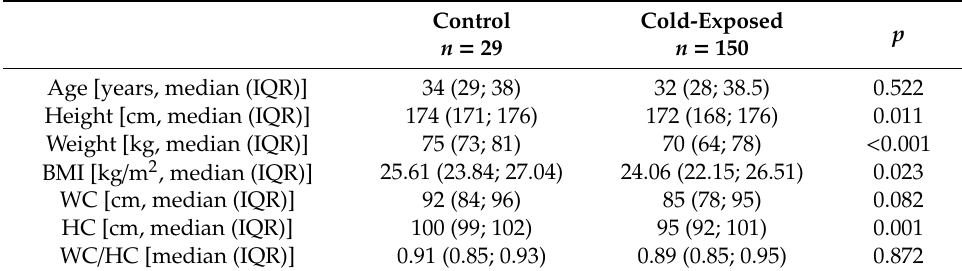
Table 2. Characteristics of subjects according to cold